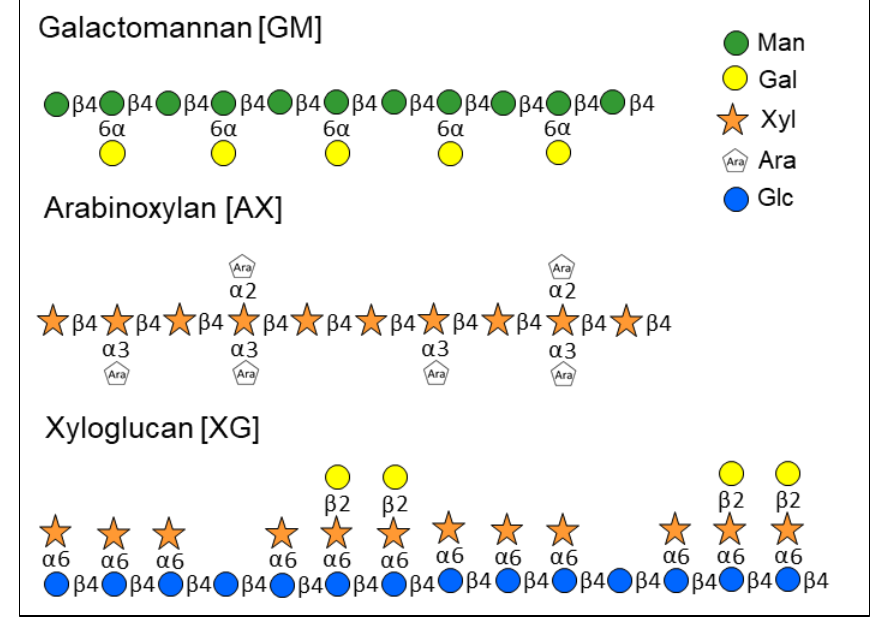
Figure 1. Schematic representation of the chemical structures of galactomannan, arabinoxylan, and xyloglucan structure.